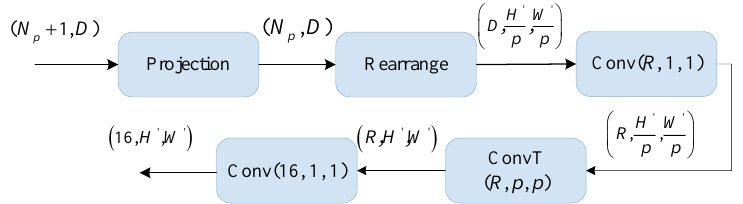
Figure 4. The structure of an image-like fusion module.